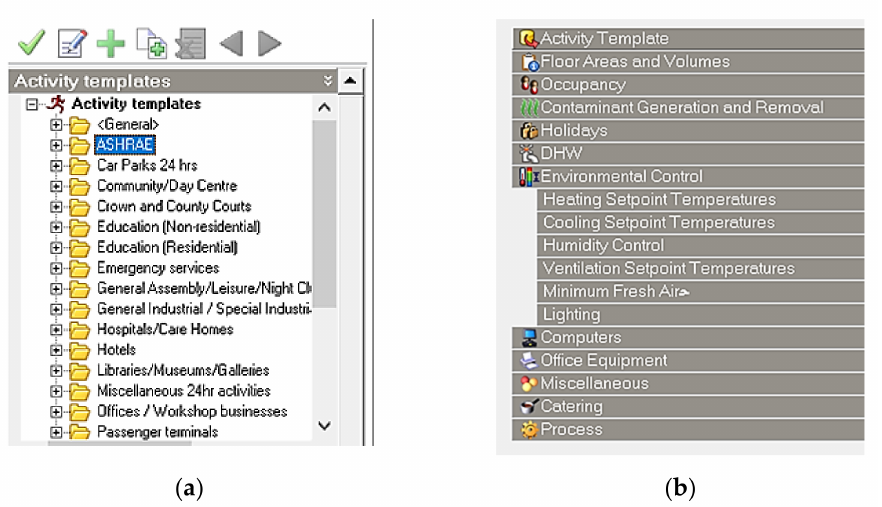
Figure 3. Modeling the building’s geometry in the environment of DesignBuilder. ( a ) Activity templates; ( b ) building simulation